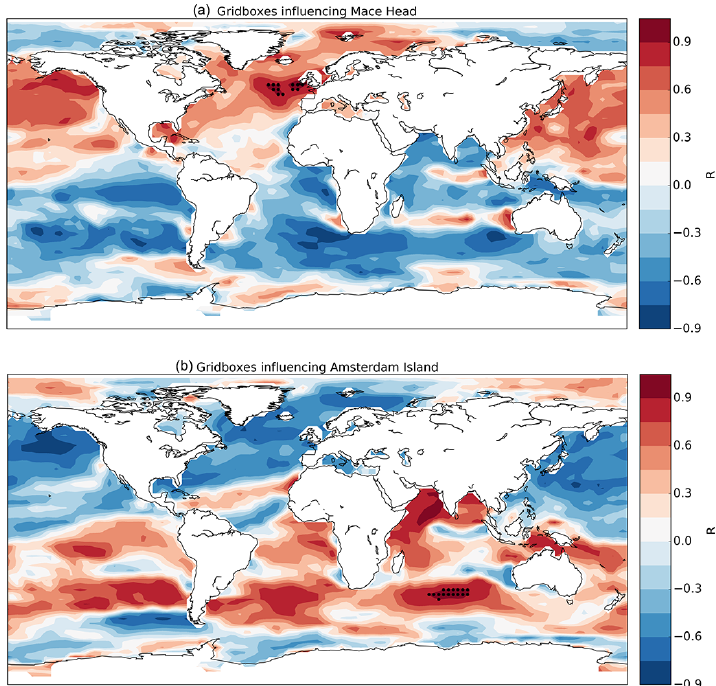
Figure A1. Linear correlation values between the monthly emission of submicron sea spray and their monthly concentrations in (a) Mace Head, (b) Amsterdam Island. The dots represent the grid boxes related to every station because they have a value R > 0 . 9.